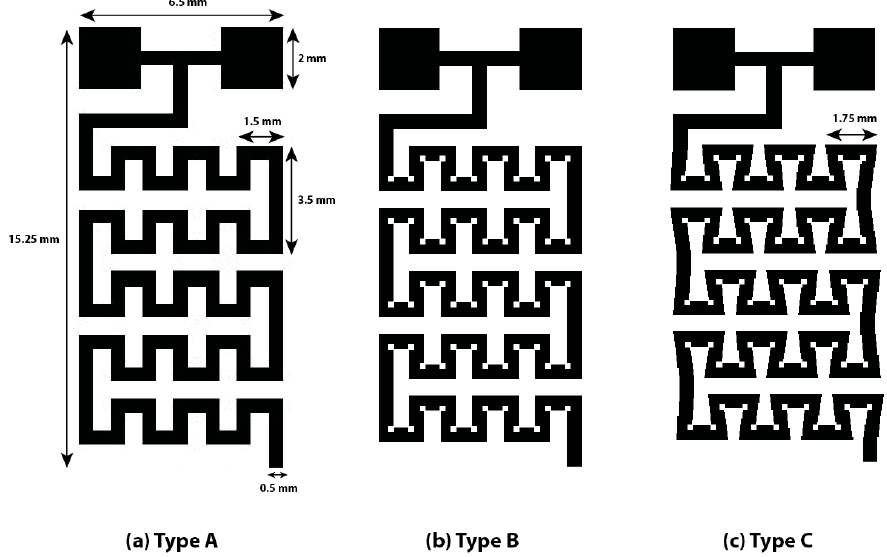
Figure 3. The proposed micro-channel with different structures in order to improve mixing efficiency. ( a ) Type A without obstacles, ( b ) Type B with obstacles, ( c ) Type C with obstacles and the more